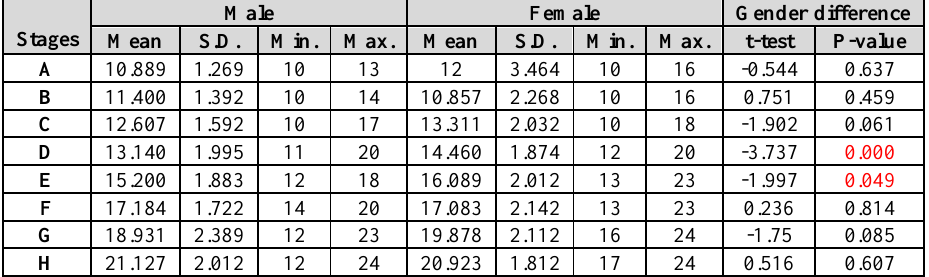
Table 4: Descriptive statistics and gender difference of age (in years) for different developmental stages of mandibular